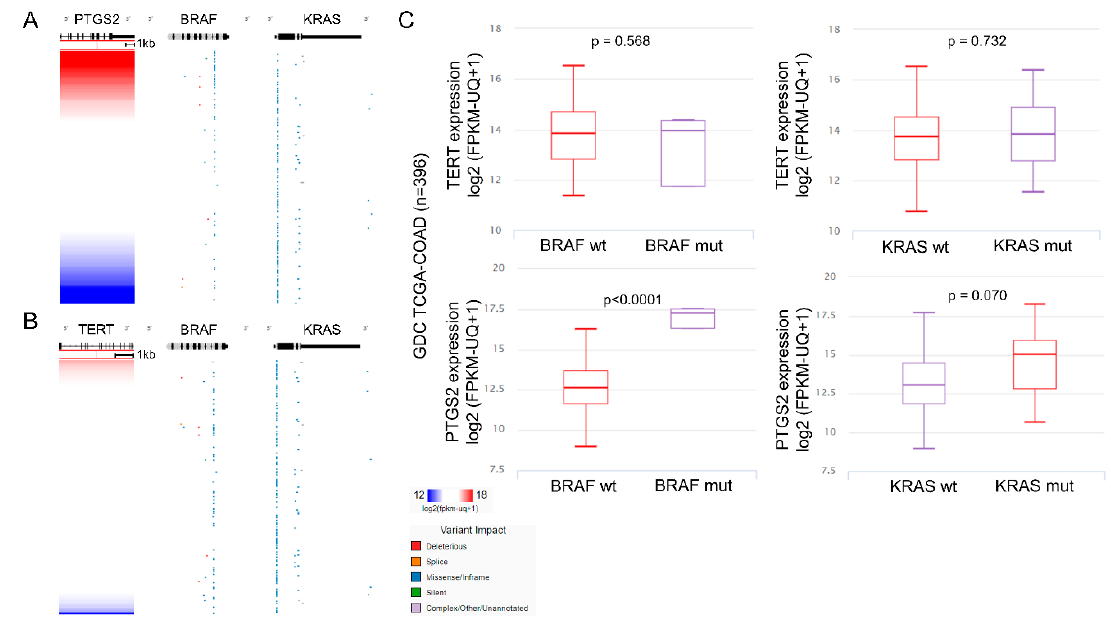
Figure 6. KRAS mutations do not affect the expression of PTGS2 (COX-2) ( A ) or TERT ( B ). PTGS2 (COX-2) expression, on the other hand, is significantly higher among BRAF mut COAD tumors carrying mainly missense/in frame and a few deleterious mutations, compared to the BRAF wt ones ( C ). KRAS, a Kirsten ras oncogene homolog from the mammalian ras gene family, encoding a protein belonging to the small GTPase superfamily; BRAF, B-Raf proto-oncogene, serine/threonine kinase; PTGS2, prostaglandin-endoperoxide synthase 2; TERT, telomerase reverse transcriptase.